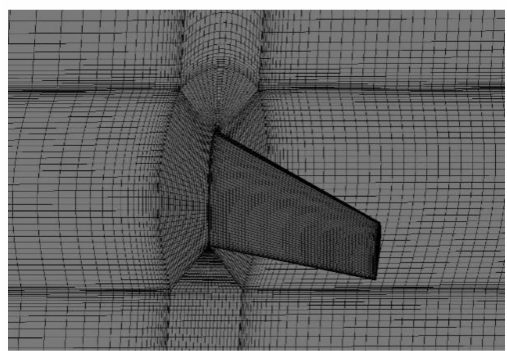
Figure 2. Grid of hydrofoil model for method validation.